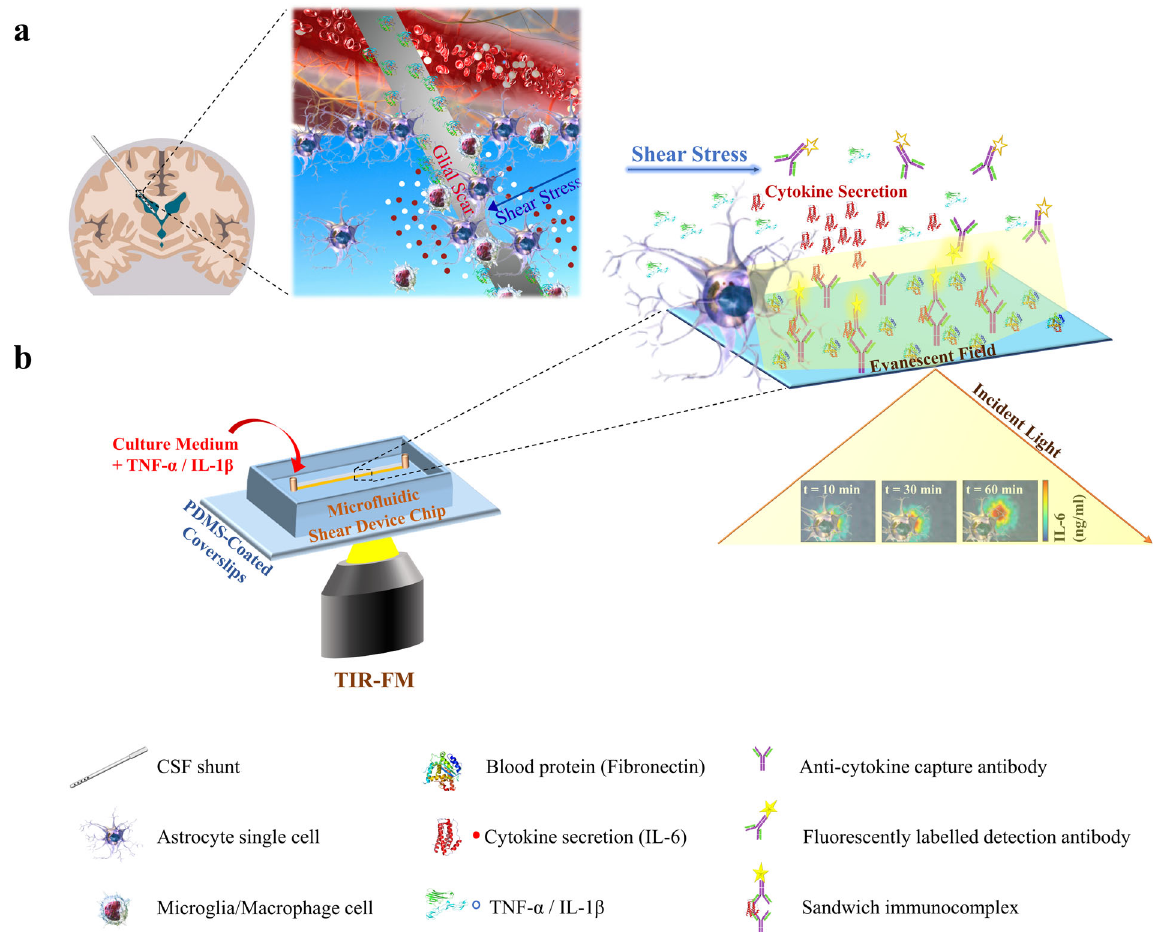
Fig. 1 Real-time spatial monitoring of live single-cell cytokine secretion assay platform for reproducing the physiological response along the shunt hole/CSF interface. Schematic of the a in fl ammatory FBR along the shunt hole/CSF interface b TIR-FM/MSDC biosensor: by taking advantage of near- fi eld excitation in TIR-FM, target cytokines in each MSDC microchannel are quanti fi ed by detecting formation of cytokine sandwich immunocomplex immediately following single-cell secretion. The anti-cytokine capture antibody immobilized on the microchannel surface, onto which secreted cytokine and fl uorescently labeled detection antibody is bound, form the sandwich immunocomplex. The detection strategy offers an advantage in its non-invasive monitoring by immobilizing and labeling target molecules in the extracellular